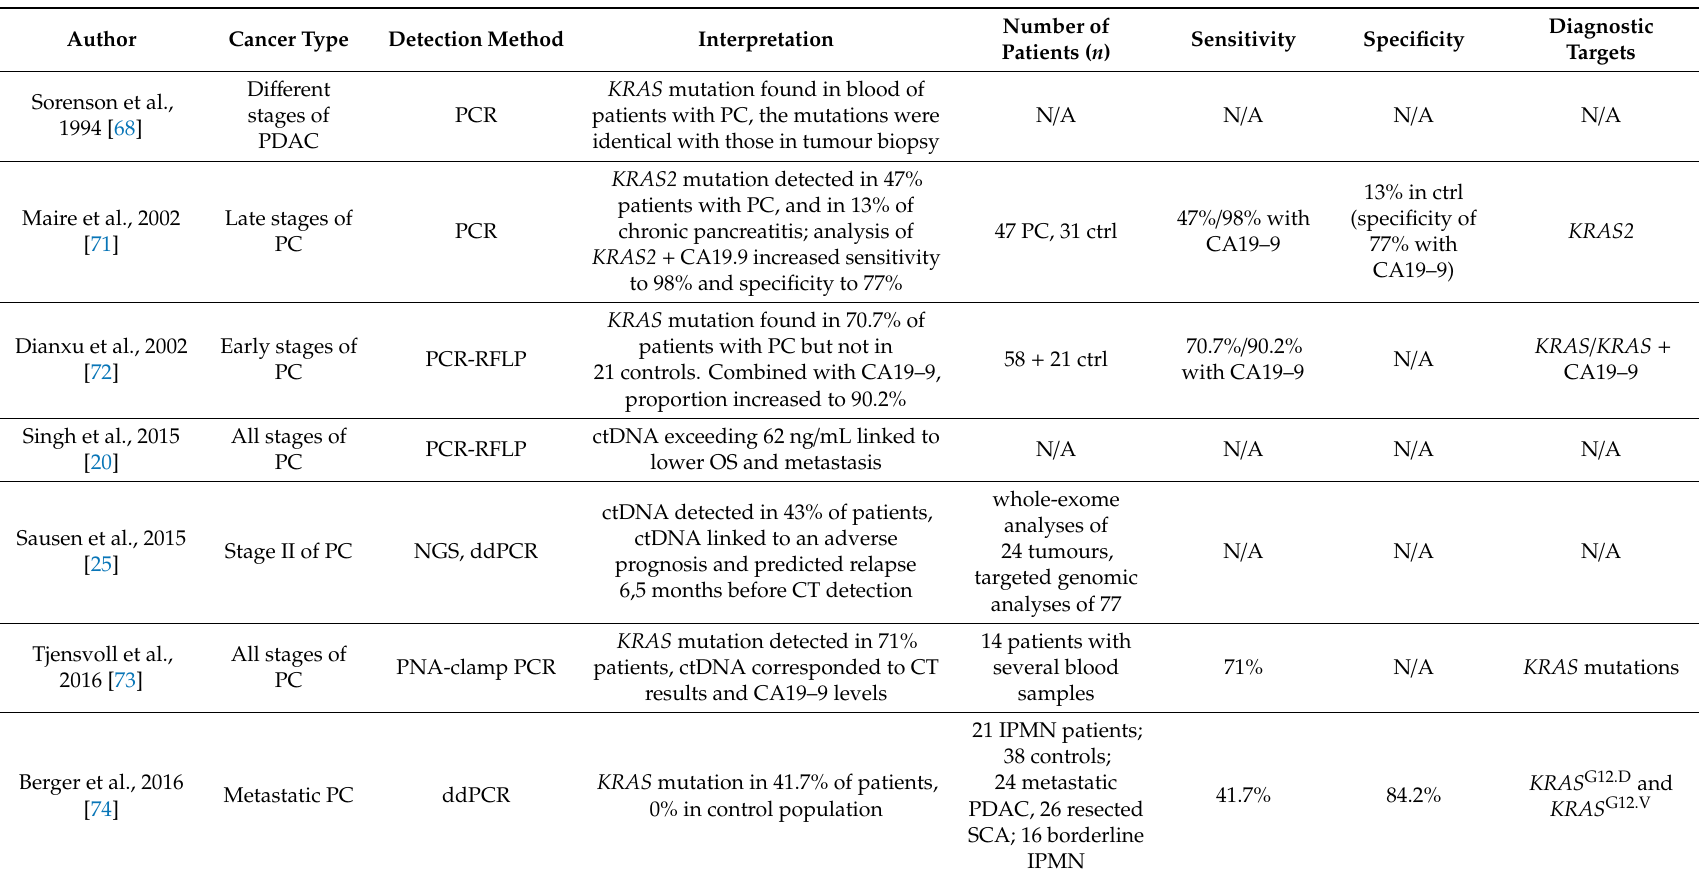
Table 1. Clinical studies investigating ctDNA in pancreatic